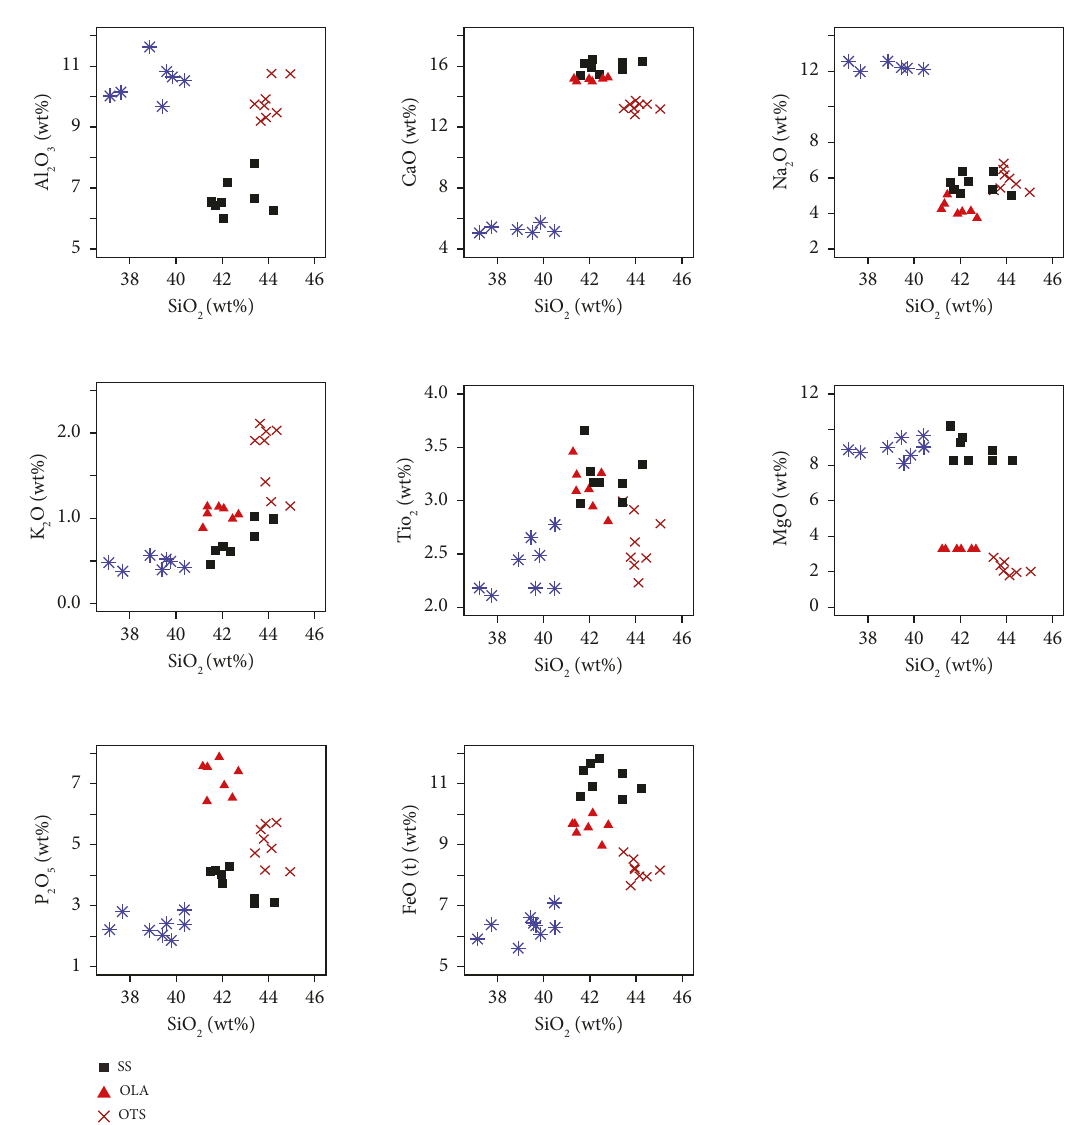
Figure 13: A multiplot of SiO 2 against major oxides of SS, OTS, OLA, and NCA samples.